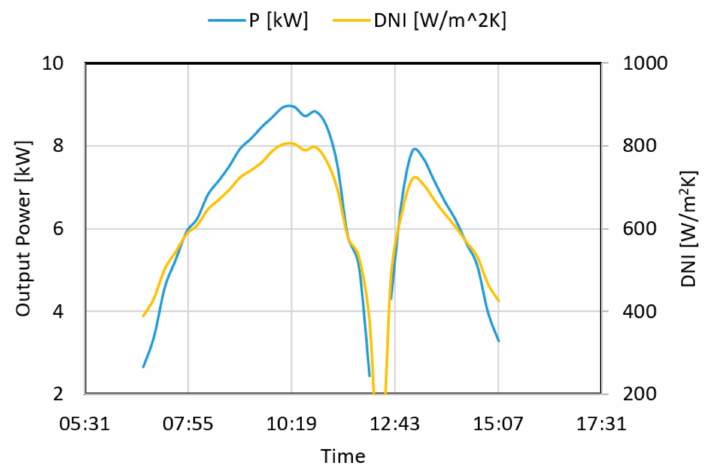
Figure 12. Daily variation of Direct Normal Irradiation (DNI) (Blue) and output power (Yellow) for a typical cloudy day in Rome,